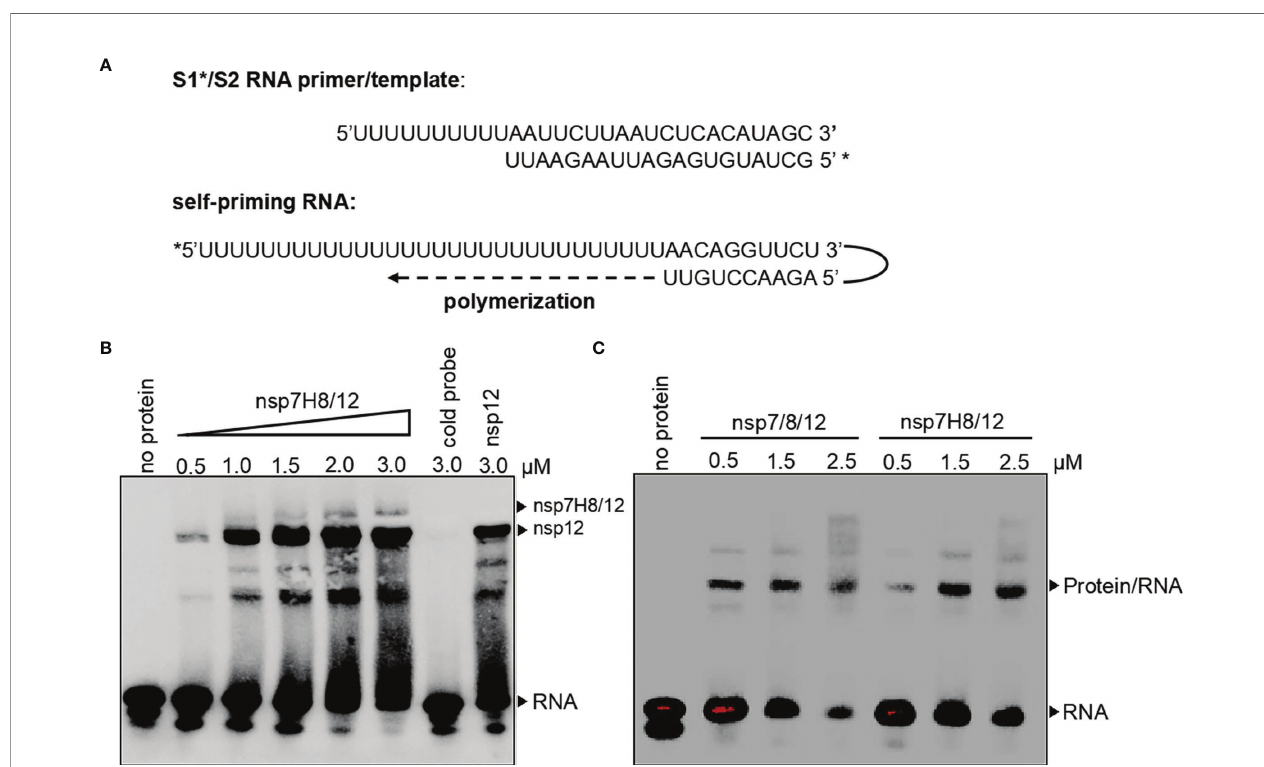
FIGURE 2 | The RdRp complex binds with primer/template RNA. (A) Schematic diagram for a short S1*/S2 RNA primer/template and a long self-priming RNA. Primers which were labeled with biotin marked by *. (B) Gel mobility-shift assay of the interaction of the RdRp complex (nsp7H8/12) with S1*/S2 RNA primer/ template. Lane “ cold probe ” contains 3 m M RdRp complex and 200-fold excess unlabeled competitor S1/S2 RNA. (C) Gel mobility-shift assays of the interaction of nsp7/8/12 or nsp7H8/12 with S1*/S2 RNA. Gel mobility-shift assays were performed using the different combinations of nsp7, nsp8, nsp7H8, and nsp12 protein puri fi ed from Sf9 cells. nsp7/8/12: His 6 -nsp7, His 6 -nsp8, and nsp12; 7H8/12: nsp7-His 6 -nsp8 and